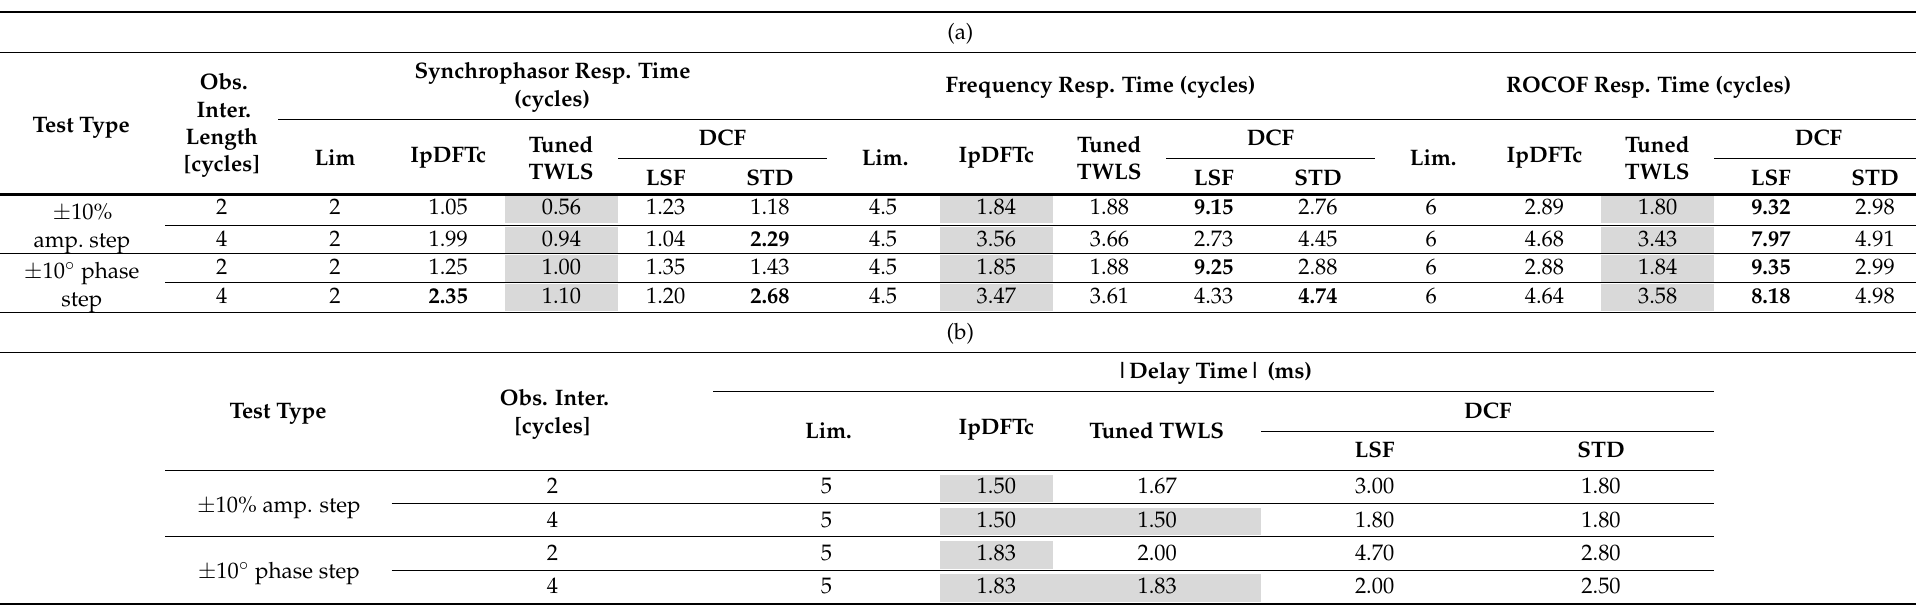
Table 6. Maximum response times (expressed in nominal power line cycles) associated with synchrophasor, frequency and ROCOF estimation (a) and maximum delay times (b), under the influence of the worst-case amplitude or phase step changes specified in the IEEE/IEC Standard 60255-118-1:2018 for P Class PMUs using 2-cycle or 4-cycle observation intervals. The limits specified in the Standard are also shown. The values exceeding the limits are highlighted in bold, whereas the cells containing the best results obtained in each test are